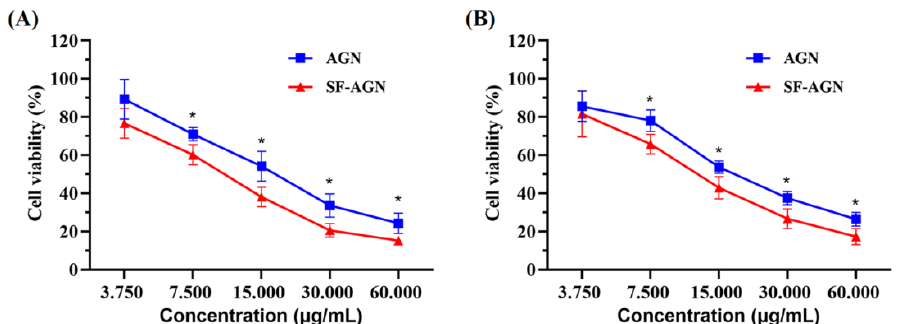
Figure 6. ( A ) Cell viability of AGN and SF-AGN with 4T1 cells after 24 h incubation; ( B ) AGN and SF-AGN with MDA-MB-231 cells after 24 h incubation. *: p < 0.05 vs. AGN.